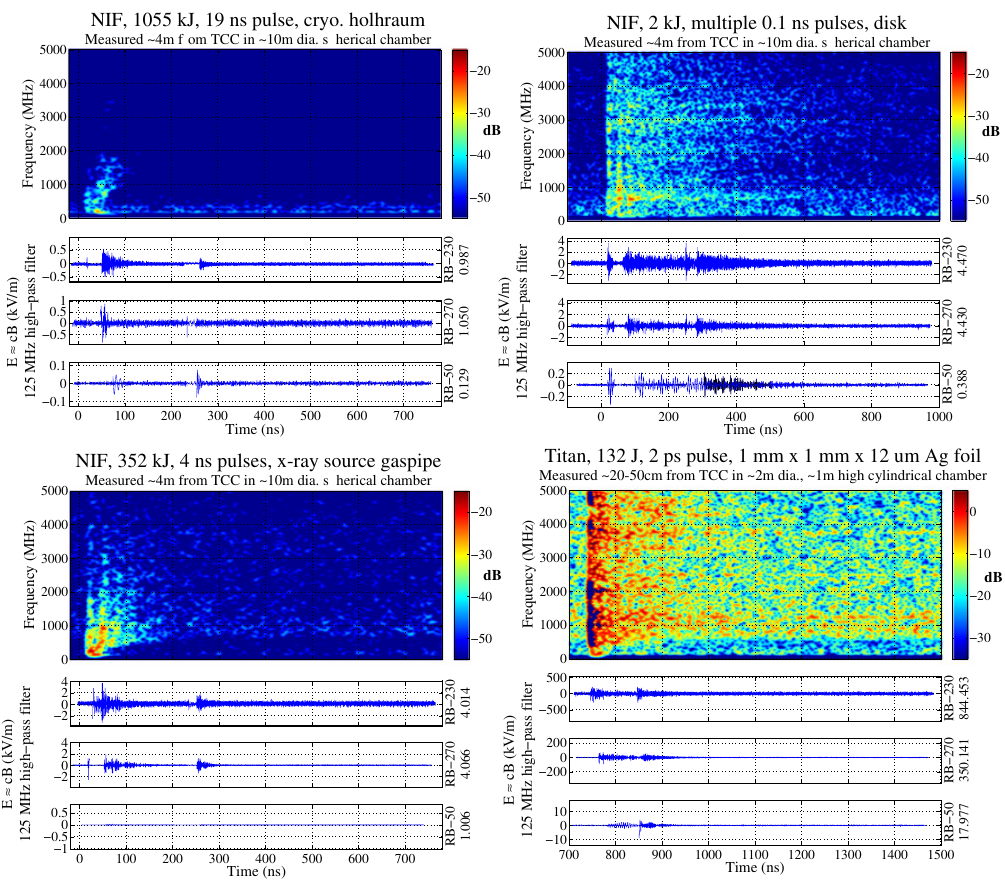
Figure 2. E-field traces and composite spectrograms for various laser energies and target